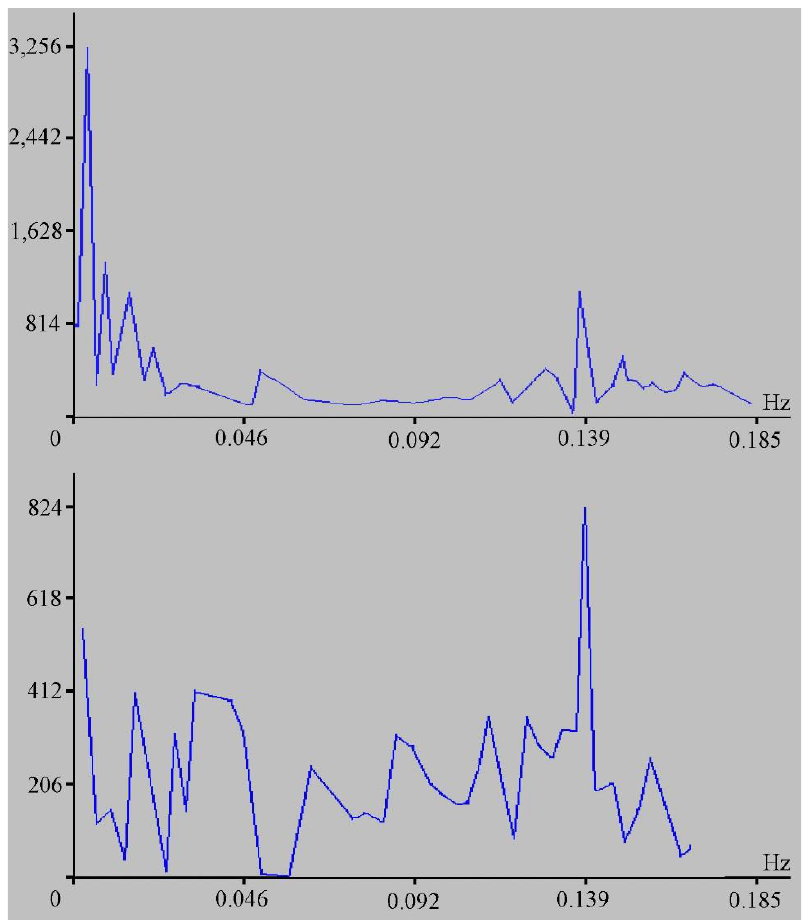
Figure 15. Spectra obtained during the processing of sections of the recordings containing anomalous disturbances ( upper ) and the background sections ( lower ) by the maximum likelihood method.